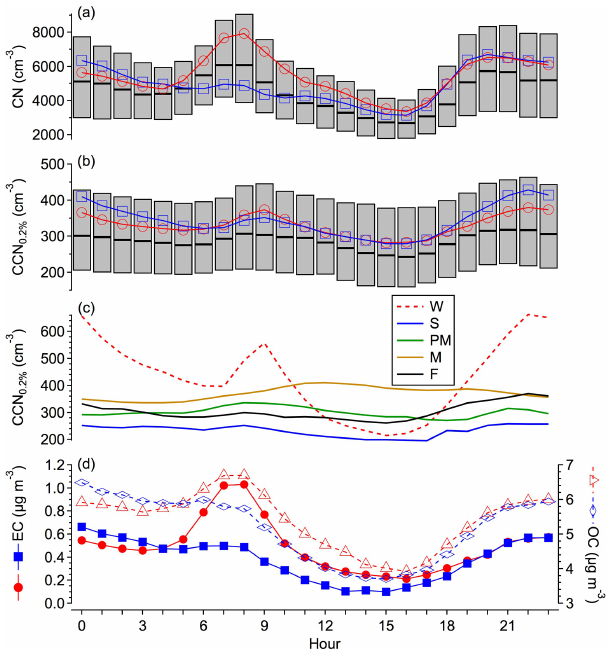
Figure 3. Hourly trends of (a) CN and (b) CCN (0.2%). Bars in- dicate median and interquartile range of the variability within each hour. Mean CN and CCN concentrations are shown for both week- days (red) and weekends (blue). Hourly trends of CCN are shown in (c) for each season. Mean EC (solid) and OC (dashed) concen- trations (d) are shown for weekdays (red) and weekends